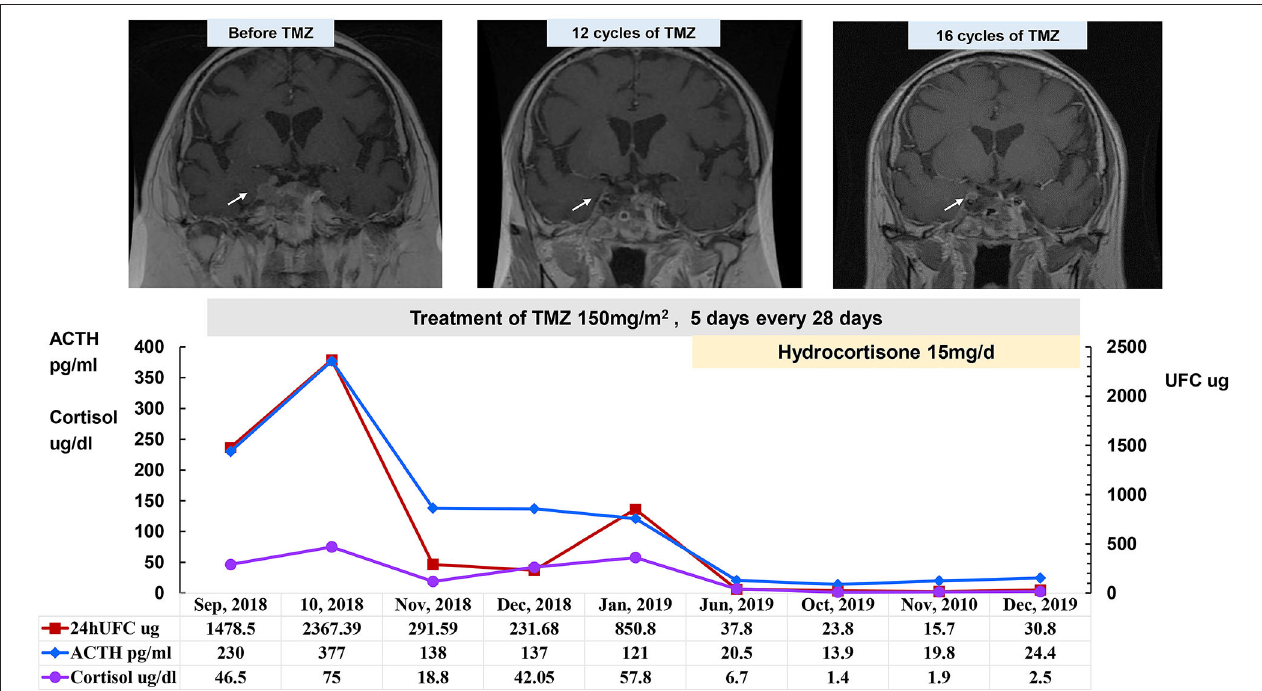
FIGURE 2 | Changes in 24-h UFC, morning ACTH, and morning cortisol levels after treatment with TMZ after transformation to a functional SCA in case 2 (September 2018–December 2019). Patient in case 2 started TMZ in September 2018 after five surgeries and three courses of radiotherapy. Serum cortisol and plasma ACTH levels returned to within the normal ranges after treatment with TMZ for 12 cycles. Hydrocortisone was temporarily suspended on the day of the 24-h UFC collection in October, November, and December 2019. Prior to TMZ treatment, enhanced MRI showed irregular boundaries and an uneven texture of the tumor tissue that invaded the right cavernous sinus; the tumor tissue was significantly reduced after TMZ